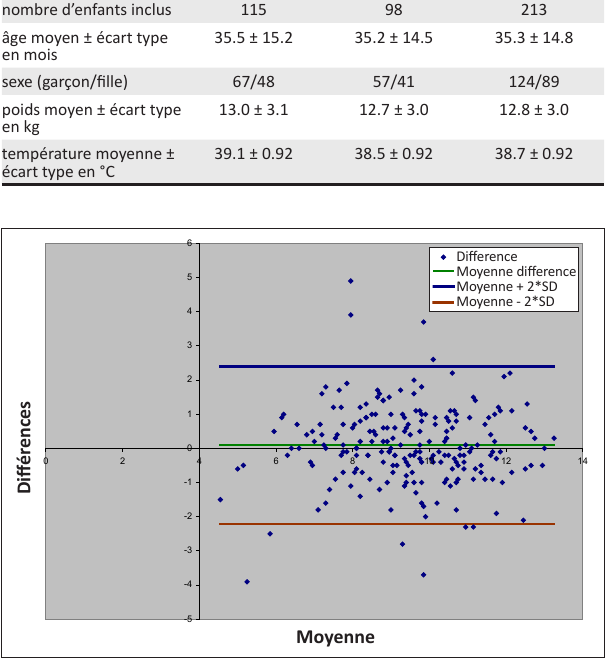
FIGURE 1: Dispersion des différences entre les valeurs du taux d’hémoglobine par la méthode Hemocue Hb201+® et la méthode analyseurs selon la méthode de Bland et